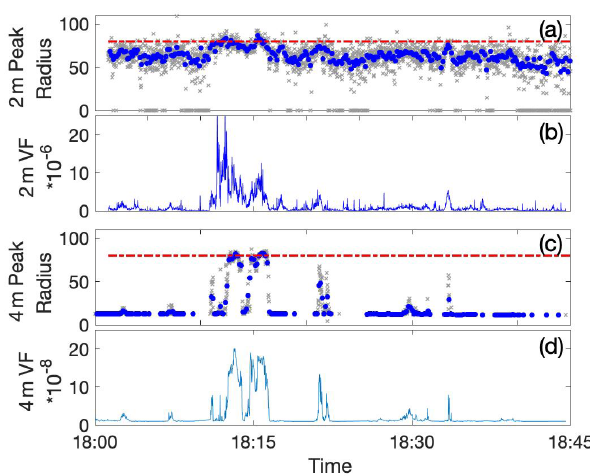
Figure 5. Comparison of fitted radius at the volume peak with void fraction during a 45min period on station 6, 2 November, 18:00:00 to 18:45:00UTC. (a) Fitted peaks at 2m, with 1s fits (grey) and 10 second averages (blue). (b) 1s void fractions at 2m, (c) fitted peaks at 4m with 1s fits (grey) and 10s averages (blue), (d) 1s void fractions at 4m. The dashed line on (a) and (c) shows 80µm radius for